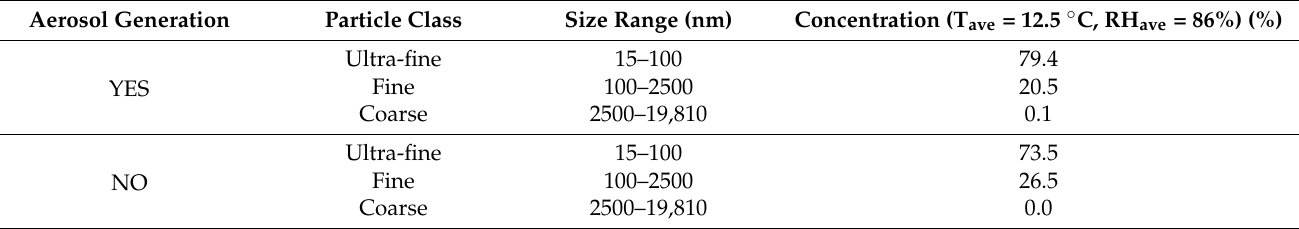
Table 1. The percentage of individual fractions of drops in the total concentration. Aerosol